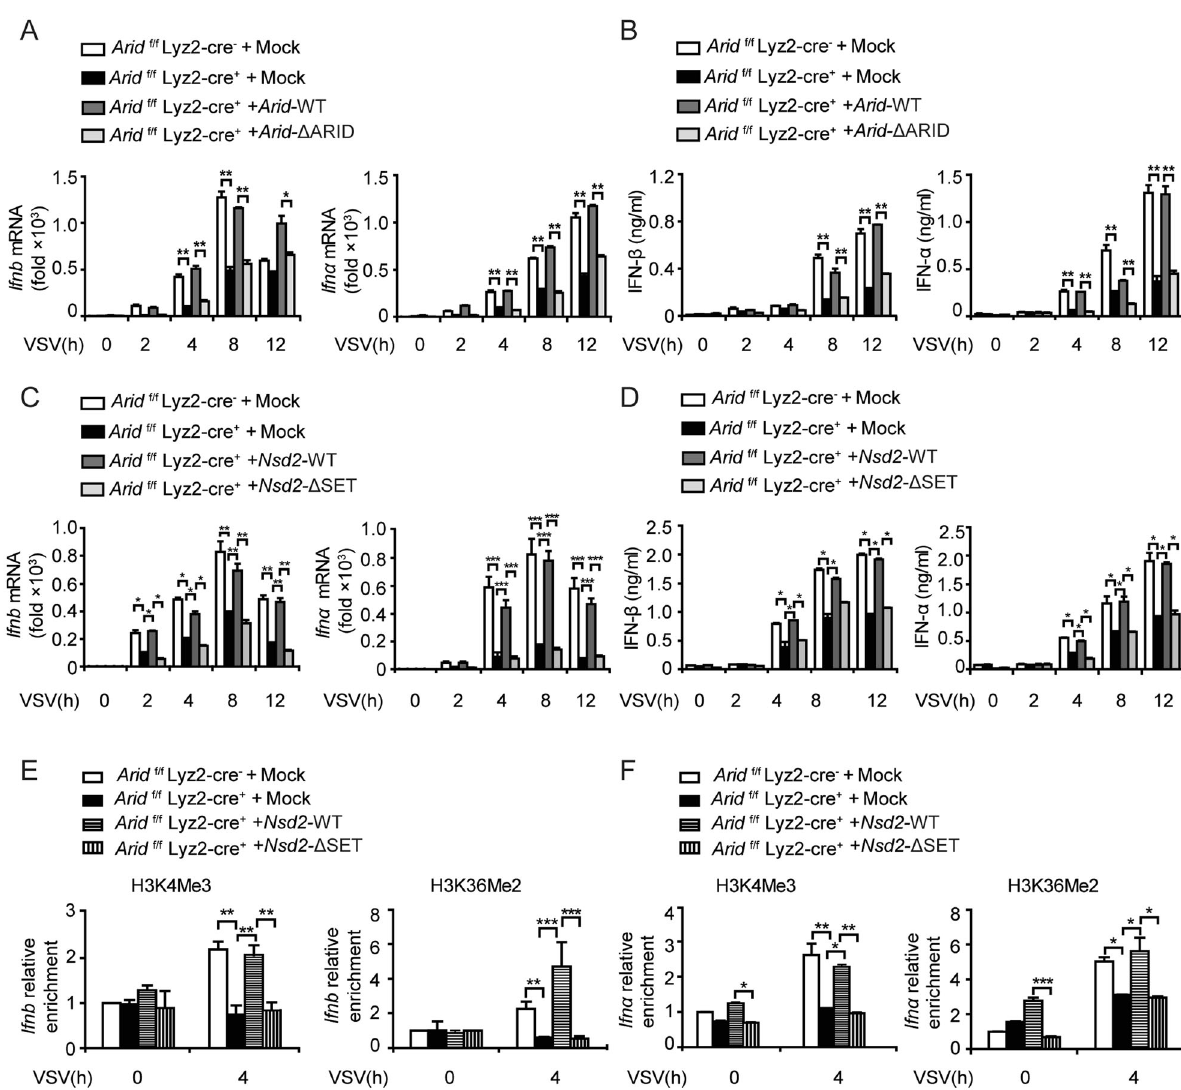
Fig. 6 NSD2 promotes IFN-I production by mediating histone methylation of Ifn-I promoters. A, B qPCR analysis of Ifn-I ( A ) and ELISA analysis of IFN-I ( B ) expression in Arid1a f/f Lyz-Cre - and Arid1a f/f Lyz-Cre + BMDMs transfected with wild type Arid1a and Arid1a- Δ ARID construct and then infected with VSV (MOI, 1) at the indicated times, mock served as control. C , D qPCR analysis of Ifn-I ( C ) and ELISA analysis of IFN-I ( D ) expression in Arid1a f/f Lyz-Cre − and Arid1a f/f Lyz-Cre + BMDMs transfected with wild type Nsd2 or Nsd2- Δ SET construct and then infected with VSV (MOI, 1) at the indicated times, mock served as control. E , F ChIP assay of H3K4Me3 and H3K36Me2 in the Ifnb ( E ) or Ifn α ( F ) promoter regions of Arid1a f/f Lyz-Cre − and Arid1a f/f Lyz-Cre + BMDMs transfected with plasmids as in ( C – D ) in response to VSV (MOI, 1) infection at the indicated times. Error bars represent s.d. Student ’ s t -test. * P < 0.05, ** P < 0.01, *** P < 0.001. All data are representative of three independent experiments with three biological replicates. ( A – F : mean ±